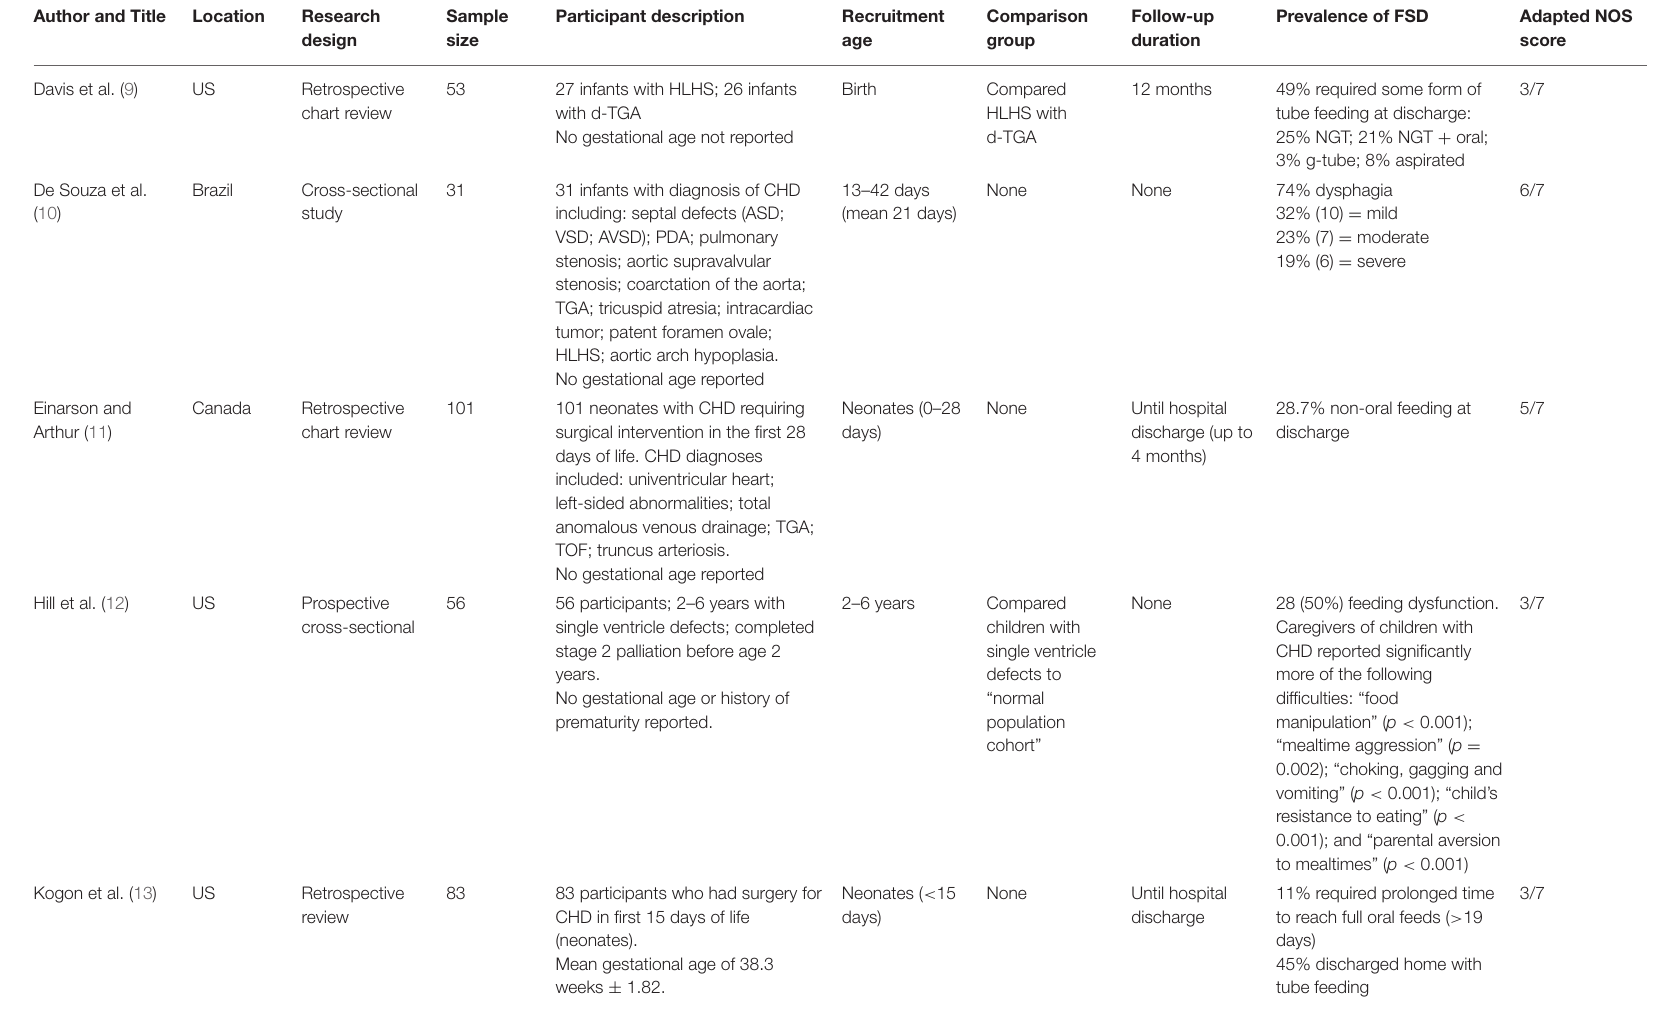
TABLE 1 | Summary of